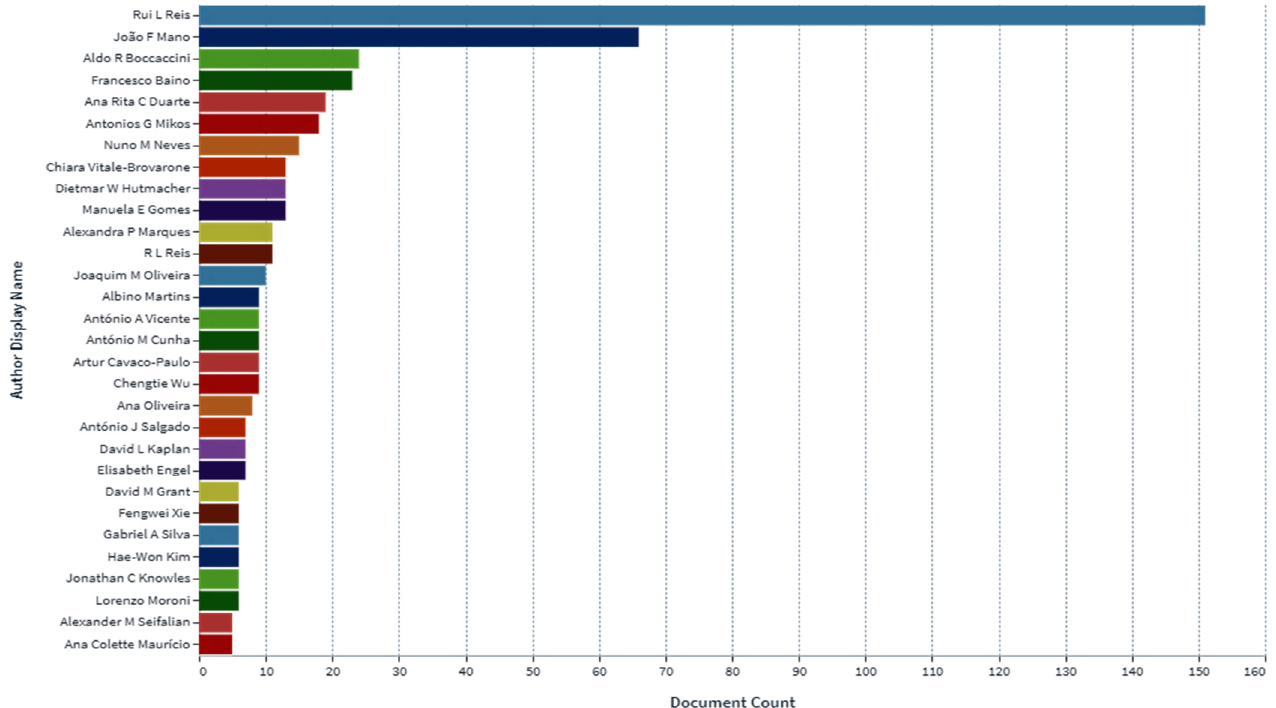
Figure 19. Number of papers published ( n = 88) according to the most active authors.